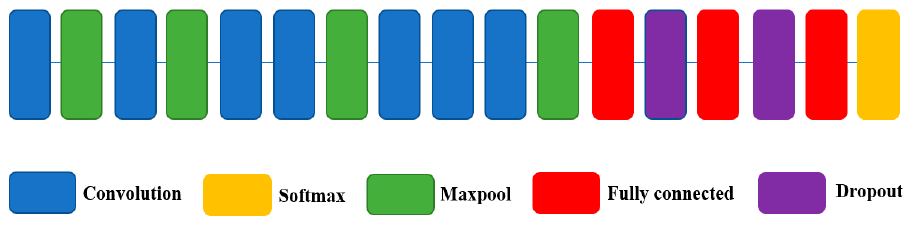
Figure 6. Schematic diagram of proposed model. Table 3. Structure of proposed model.